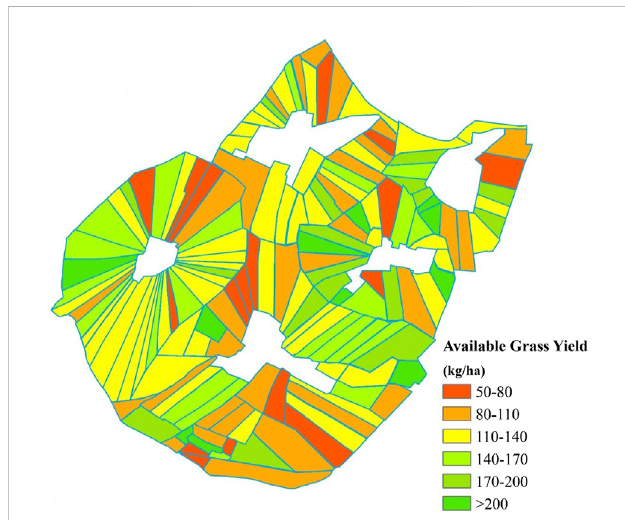
FIGURE 7 Distribution map of feed supply based on available grass yield in desert grassland in